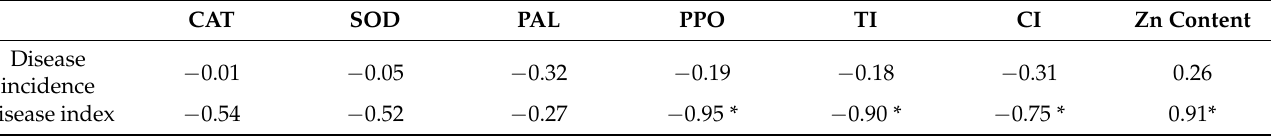
Table 3. Correlation analysis between pathogenesis parameters of leaf rust and Zn content or chem- ical defense parameters. CAT